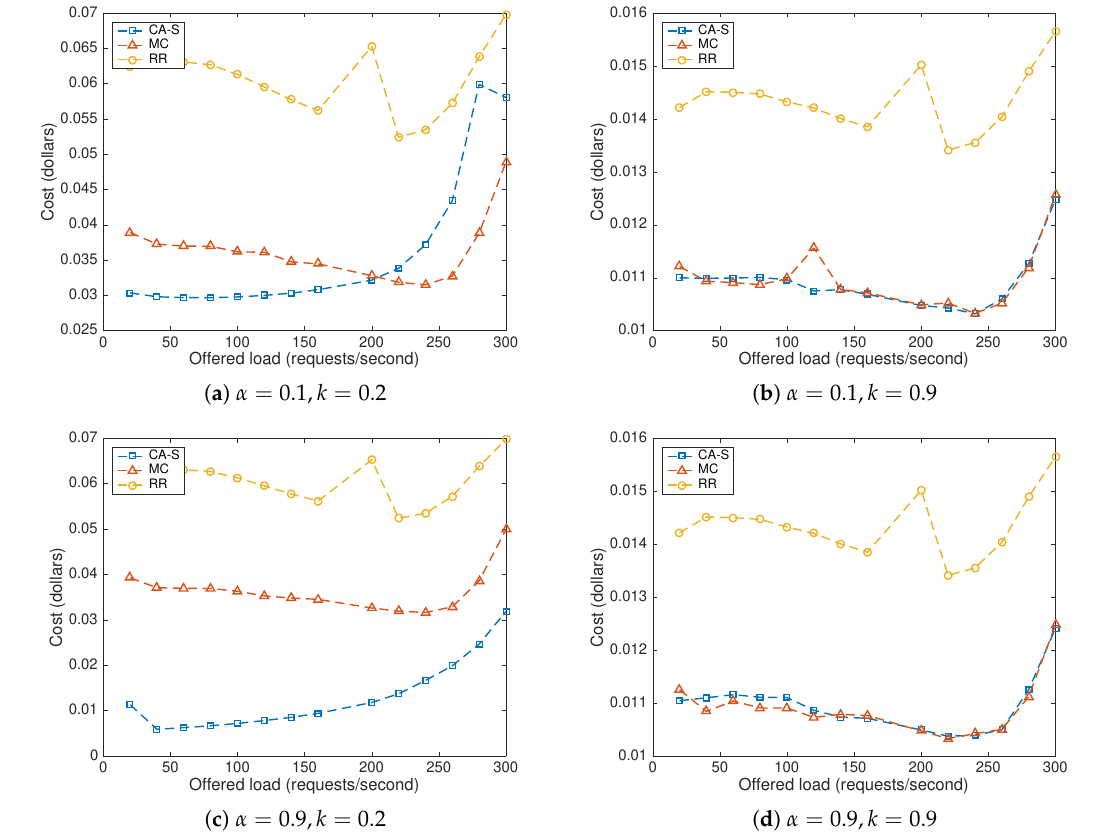
Figure 11. Combined cost with CA-S in price scenario-II.